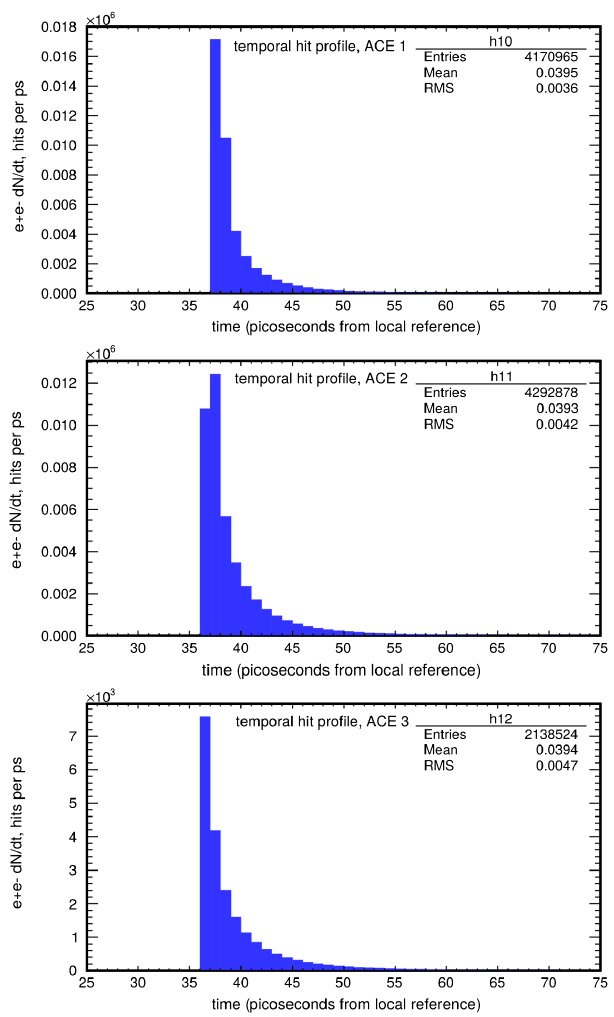
FIG. 4. GEANT 4 simulation time profiles of total charge in the three ACE elements ACE1 (top) through ACE3 (bottom), averaged over 10 5 events. This is for the case of 12.16 GeV showers and a full set of tungsten absorbers